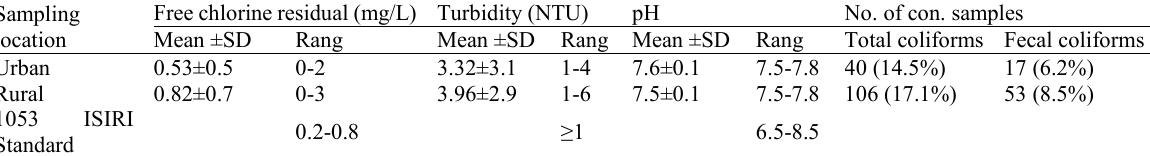
Table 3. Comparison of parameters with 1053 standard